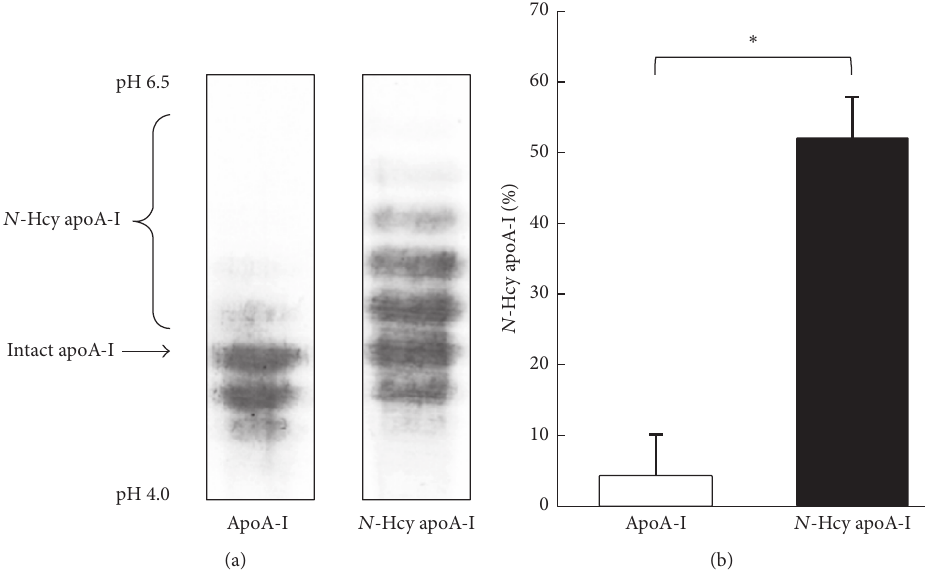
Figure 6: Isoelectric focusing for apoA-I and apoA-I treated with homocysteine thiolactone. (a) Representative isoelectric focusing patterns of apoA-I and N -Hcy apoA-I. Purified apoA-I was incubated with or without 10mmol/L of homocysteine thiolactone at 37 ∘ C for 6 hours. After dialysis against PBS, the samples were analyzed by isoelectric focusing followed by western blotting using anti-apoA-I antibody. (b) Histogram represents the percentage of N -Hcy apoA-I to total apoA-I using CS analyzer. The values were indicated by mean + SD ( 𝑛 = 3, ∗ 𝑃 < 0.05).